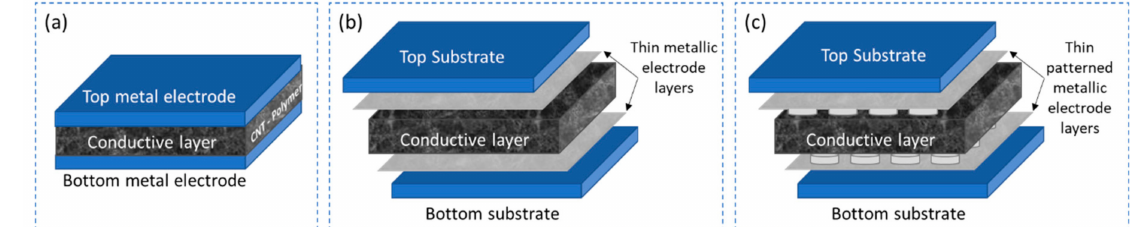
Figure 8. The parallel plate capacitive pressure sensor with conductive sensing layer can be categorized in certain forms ( a ) generic form with metallic electrodes, ( b ) thin metallic layers deposited on the substrate acting as electrodes and ( c ) patterning the metallic layer to enhance the